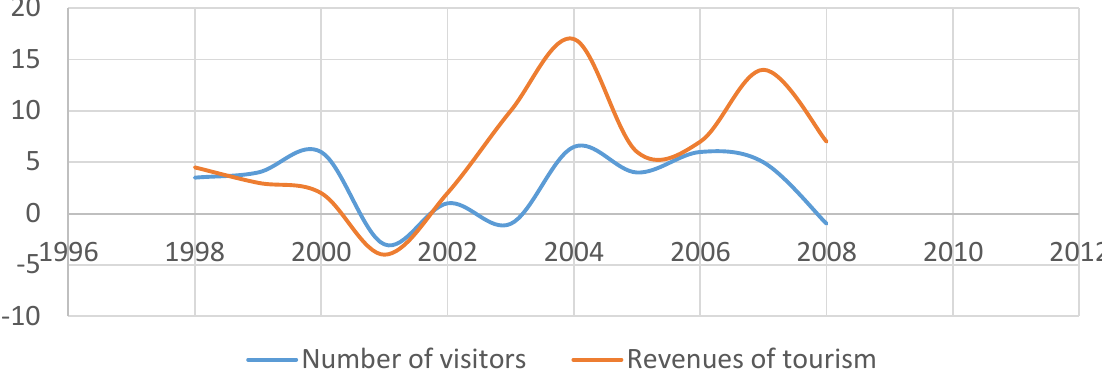
Figure 4. Development of the number of visitors and revenues from tourism for the period 1998–2008 (values representing the average of percentual year-to-year differences of 23